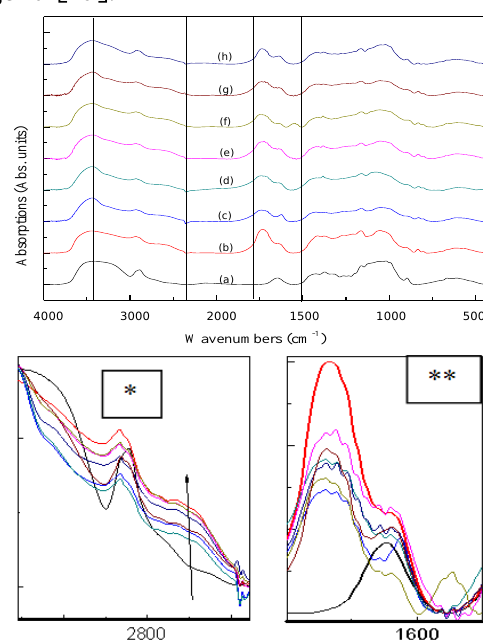
Fig. 3. FT-IR spectroscopy of (a) VR, (b) VRS, VRS with metal ion complexes: (c) Cu 2+ 4.2mmol/g at pH 5, (d) Ni 2+ 0.91mmol/g at pH 6, (e) Zn 2+ 0.69mmol/g at pH 6.3, (f) Pb 2+ 0.83mmol/g at pH 5, (g) Ag + 0.35mmol/g at pH 8, and (h) Cr 3+ 1.42mmol/g at pH 4.